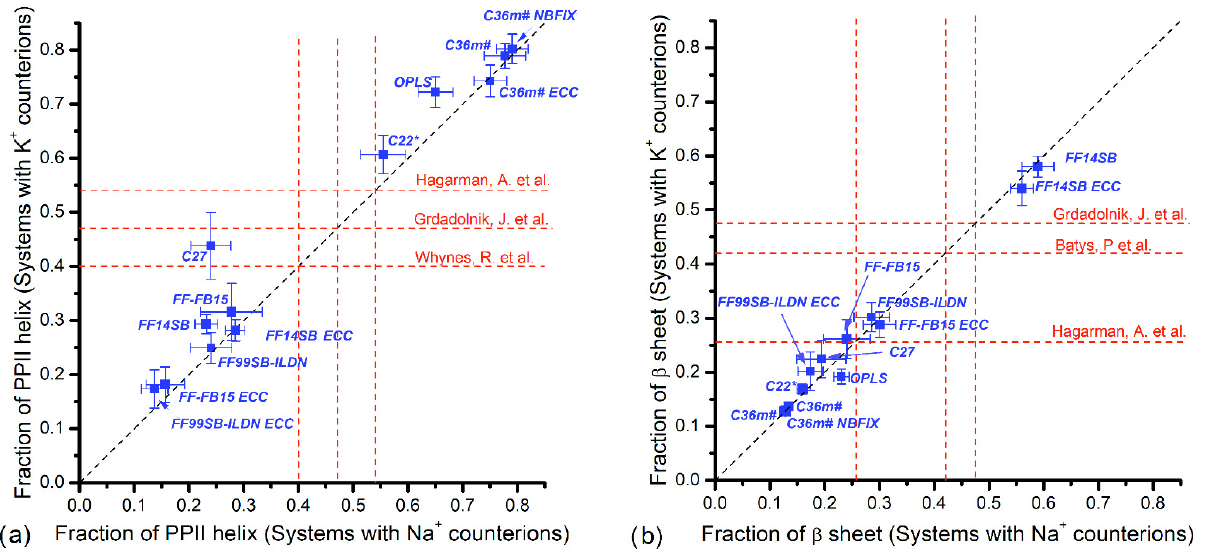
Figure 7. PGA: Fractions of ( a ) PPII helices and ( b ) β -sheet conformations with Na + vs. K + counteri- ons. Vertical and horizontal dashed lines correspond to available experiment data.